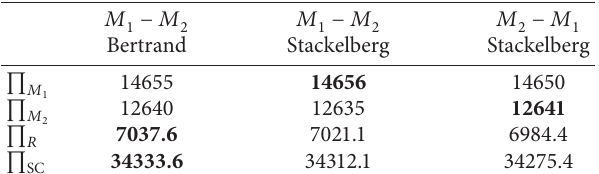
Table 4: Maximum profits of every firm and the total system under different